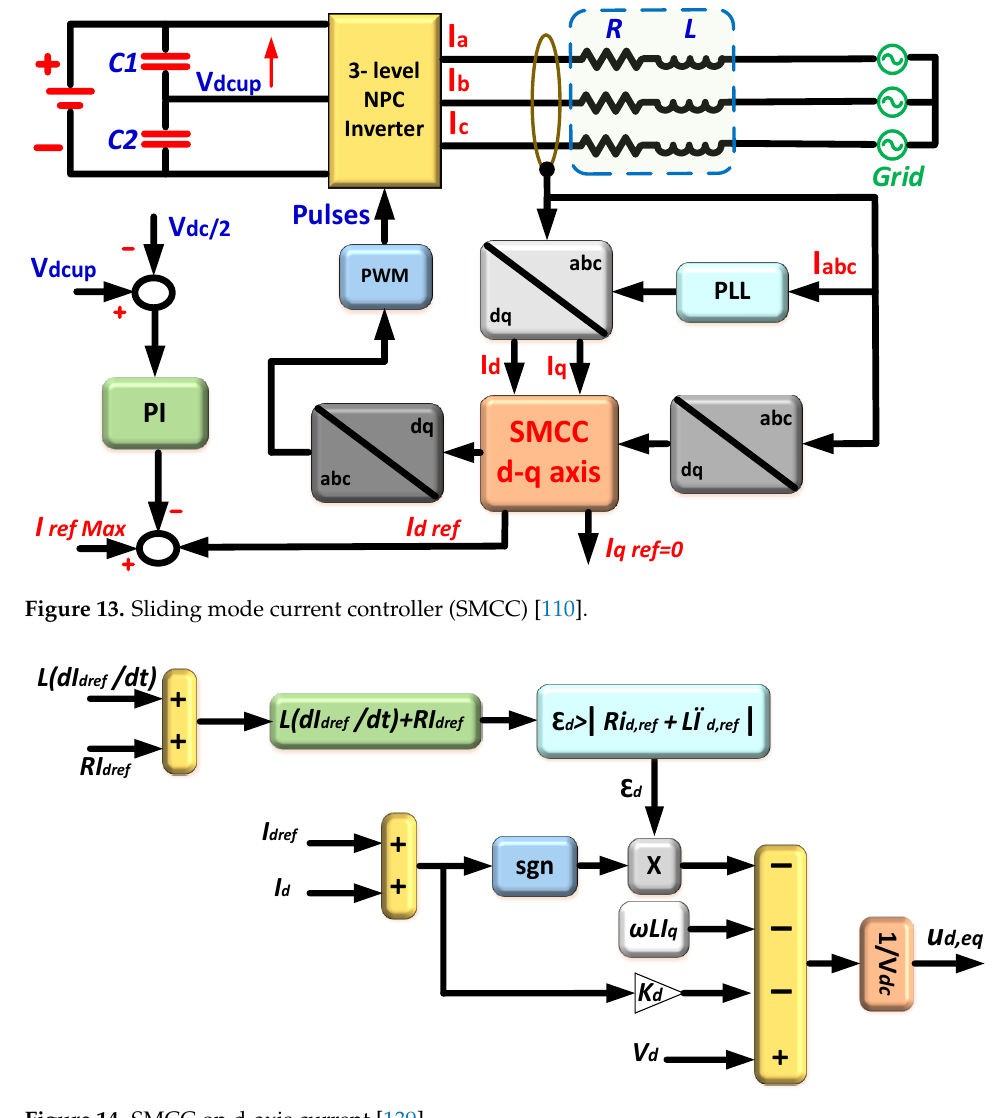
Figure 14. SMCC on d-axis current [139].